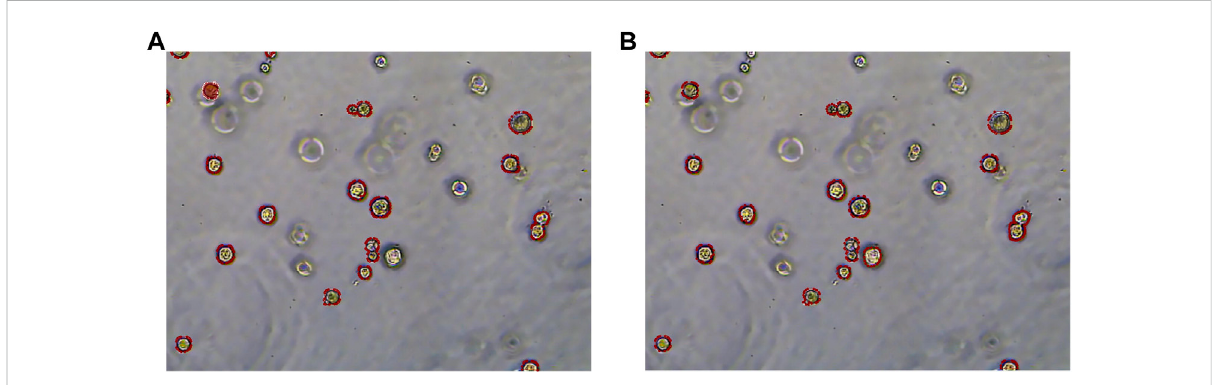
FIGURE 13 Segmentation results of the RDAU-Net model compared with manual annotation. (A) Manual labeling of organoids. (B) RDAU-Net model labeling of organoids (the red markers indicate targeted organoids).The comparison betweenFigure 13A and Figure 13B shows that the result of our model labeling is already very close to that of manual labeling.